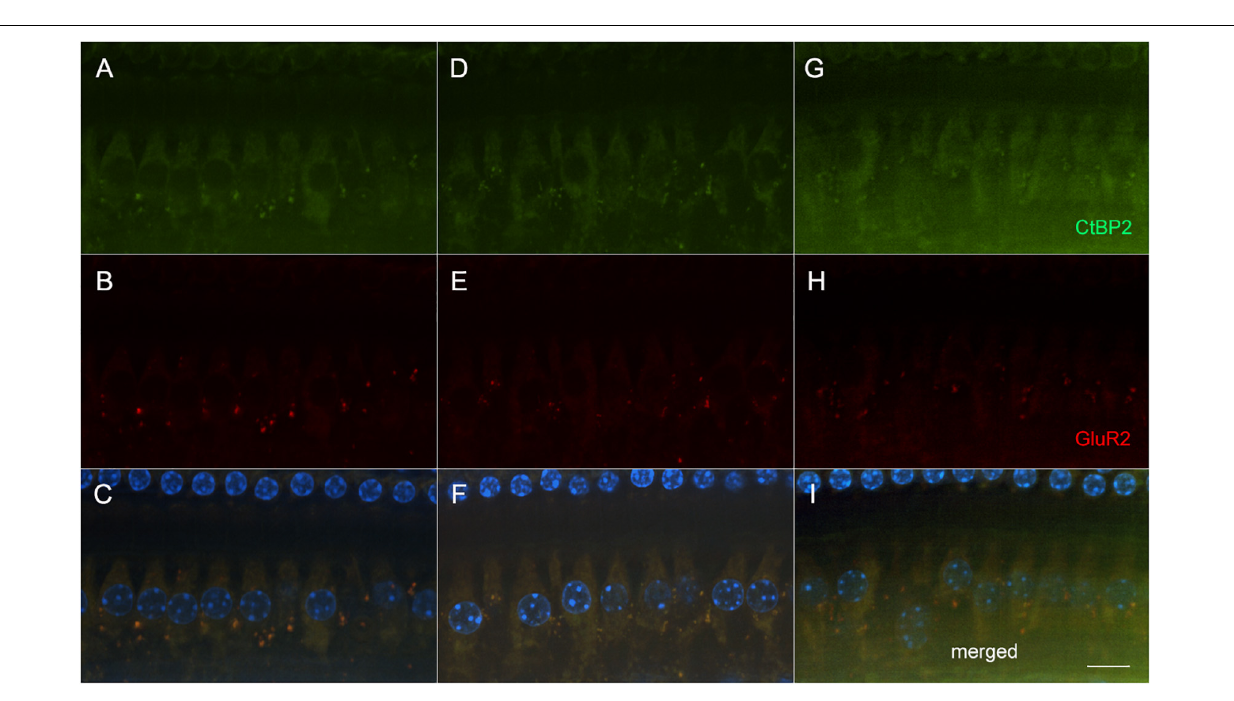
FIGURE 4 | Representative micrographs showing pre and post-synaptic densities in the 20 kHz region in three groups following AG treatment ( A–C : untreated controls , D–F : amikacin + DMSO, and G–I : amikacin + ebselen). No observable differences of immunolabeled presynaptic marker CtBP2 (green; A,D,G ), post-synaptic marker GluR2 (red; B,E,H ), or the merged images which include hair cell nucleus marker DAPI (blue; C,F,I ) were seen between groups. Scale bar = 10